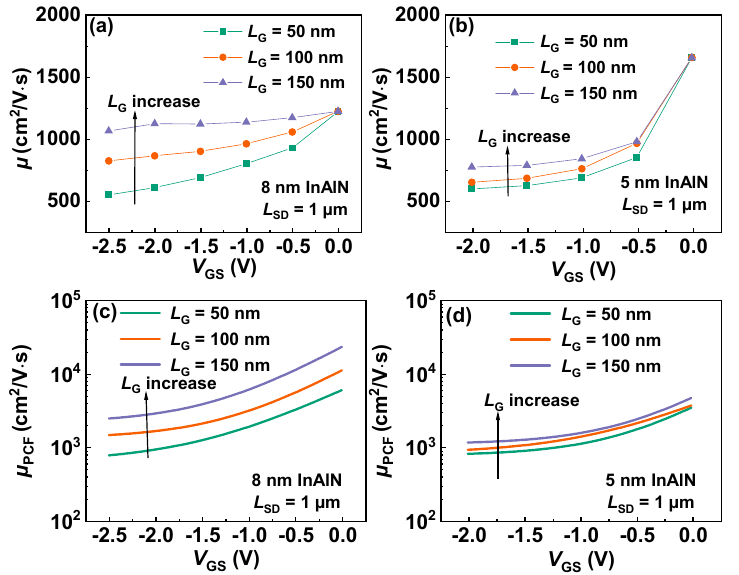
Figure 12. ( a , b ) µ versus V GS for the devices with L SD of 1 µ m and L G of 50, 100, 150 nm with 8 nm and 5 nm InAlN. ( c , d ) Calculated µ PCF versus V GS of the same devices with 8 nm and 5 nm InAlN.